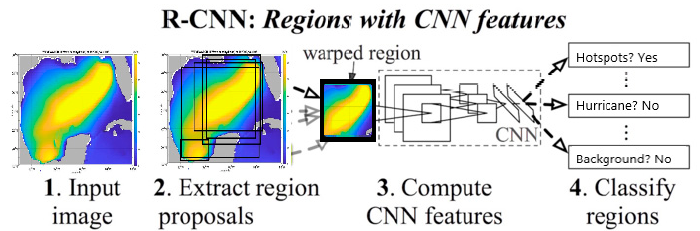
Figure 1. Sample structure of a regional CNN.